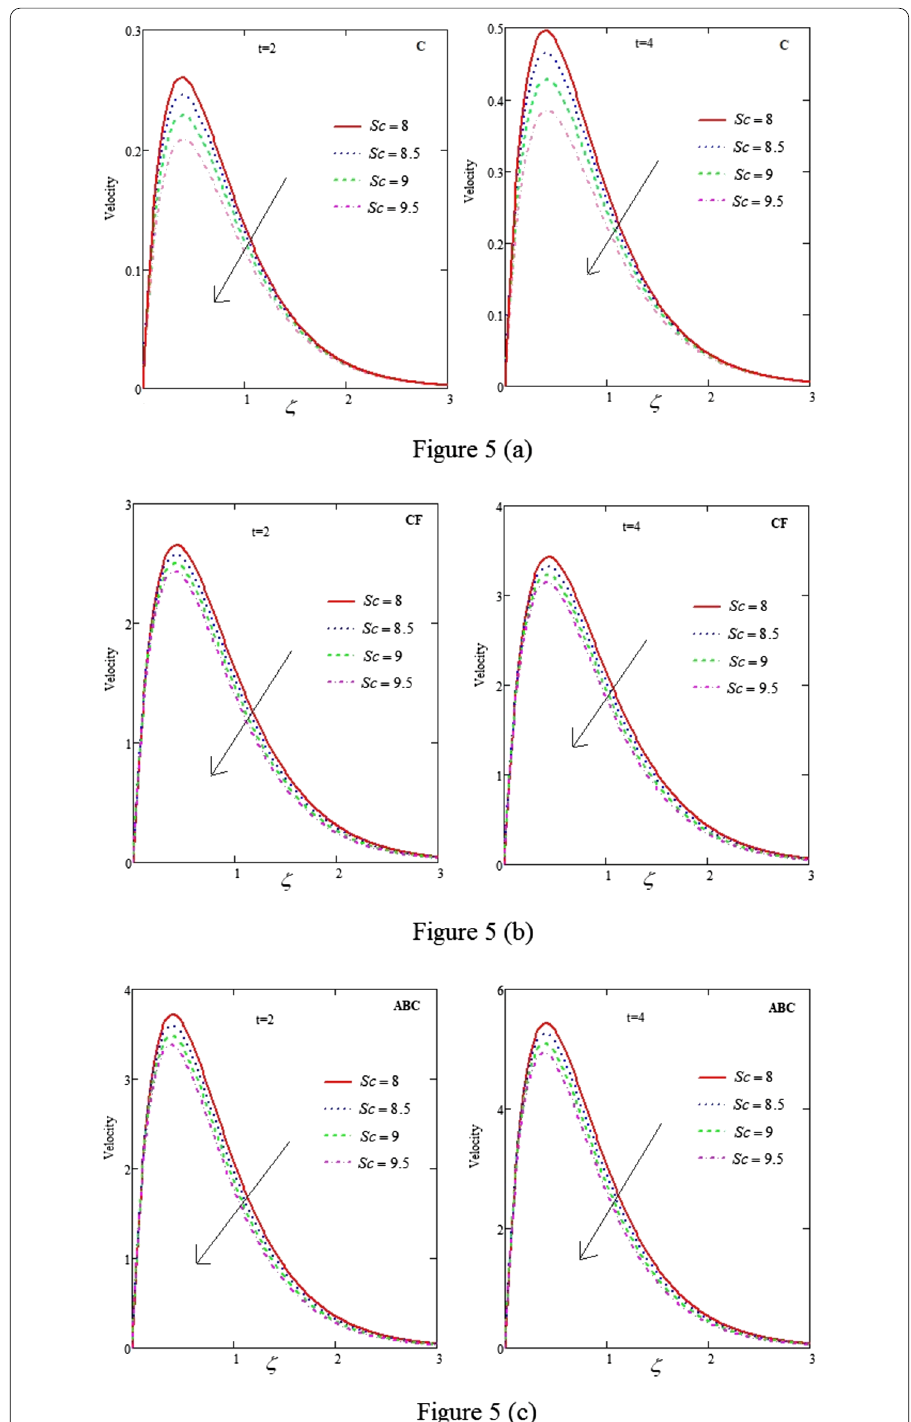
Figure 5 ( a , b , c ). Velocity curves belonging to C, CF and ABC for various values of Sc , where γ = 0.1, Pr = 6, λ = 0.2, Gr = 6, Gm = 8 and M =